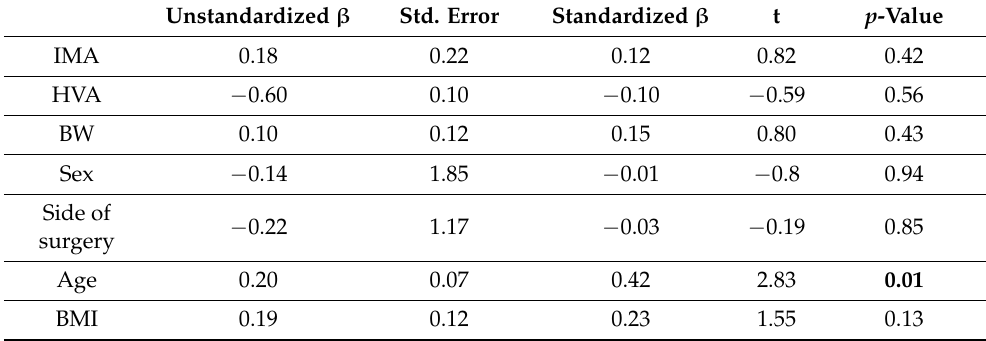
Table 5. Multivariate analysis of STW change by IMA, HVA, BW, sex, side of surgery, age, and BMI. Unstandardized β Std. Error Standardized β t p